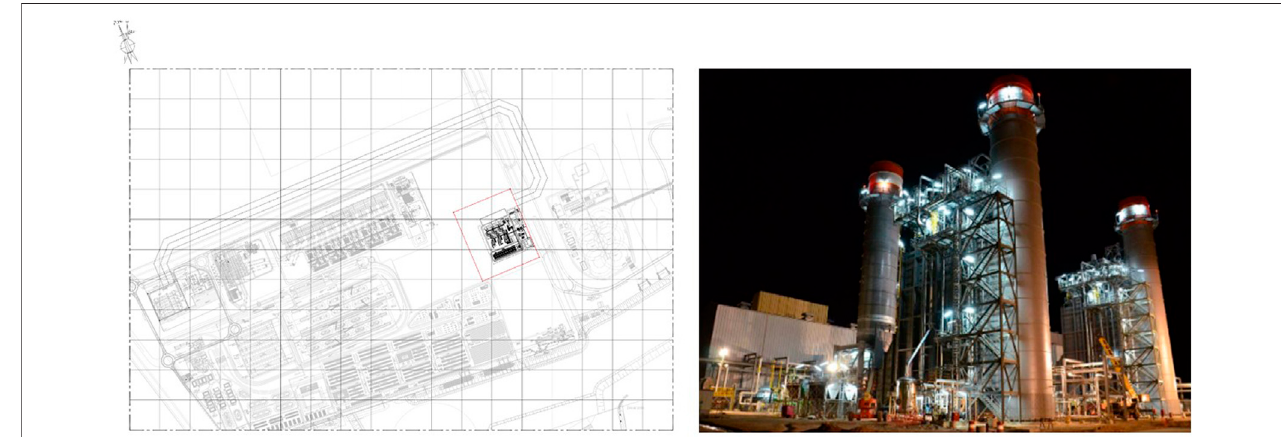
FIGURE 3 | Project layout drawing and water treatment plant